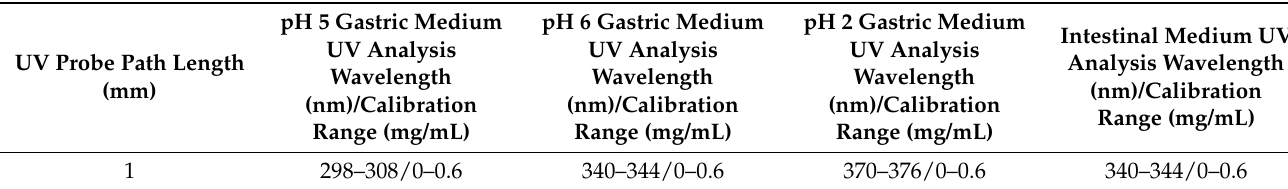
Table A3. UV analysis wavelengths and calibration ranges for gastric to intestinal transfer dissolution test using a Pion µ Diss TM Profiler.